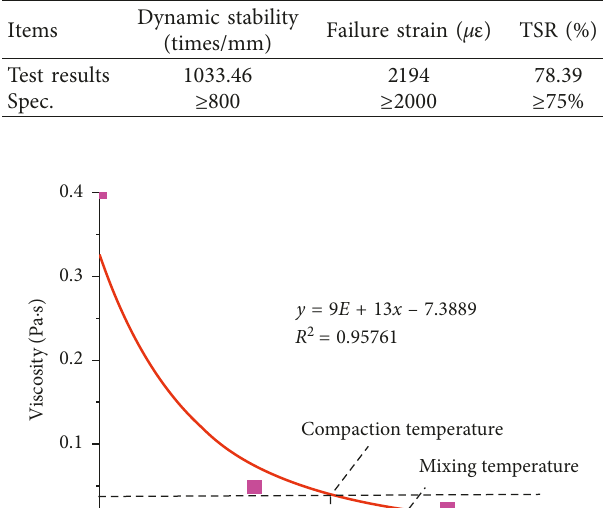
Table 8: Performances of the RH-WMA.